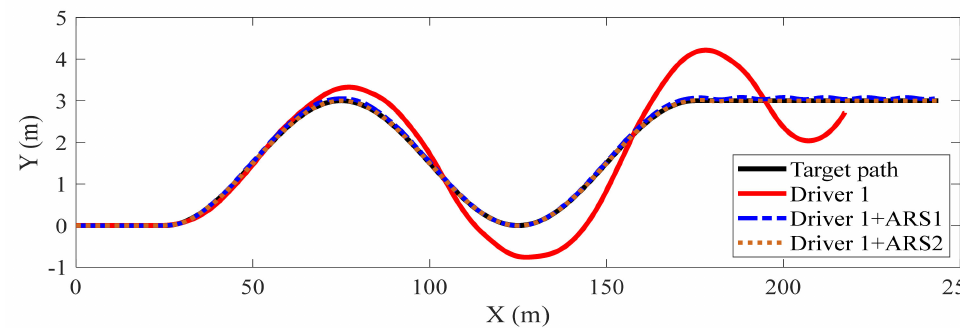
Figure 9. Moving trajectories of vehicles in Case B.